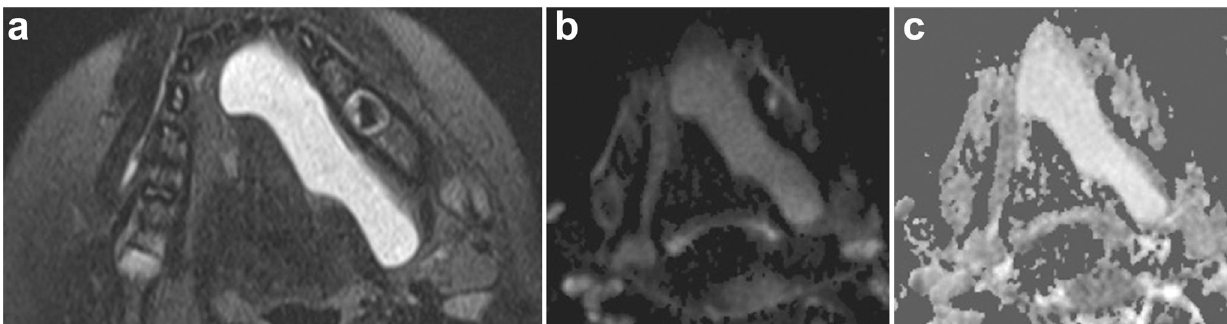
Fig. 6 Sublingual space ranula. a Axial T2-weighted MR image shows a high-signal lesion within the left sublingual space. b Axial diffusion- weighted image and c ADC map demonstrates lack of restricted